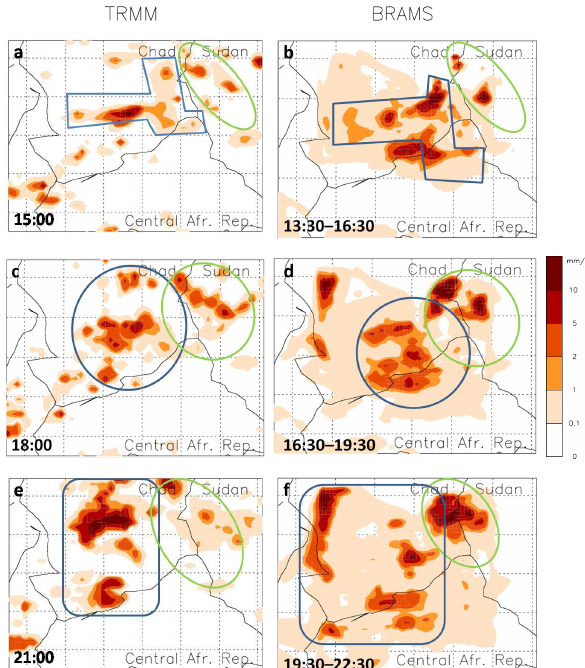
Fig. 7. Comparison between TRMM ( a, c, e ) and BRAMS ( b, d, f ) surface rainrate accumulated over 3h periods for the Chad case. Panel (a) and (b): from 13:30UT to 16:30UT on 4 August 2006. Panel (c) and (d) from 16:30 to 19:30UT. Panel (e) and (f) from 19:30UT to